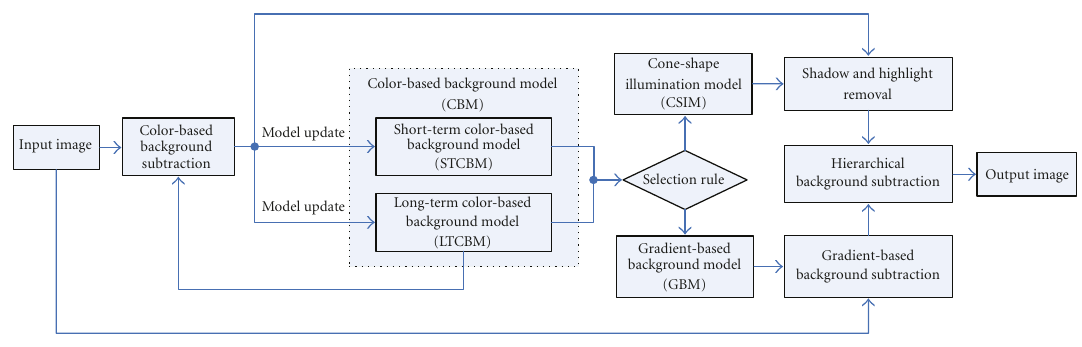
Figure 1: Block diagram showing the proposed scheme for background subtraction with shadow